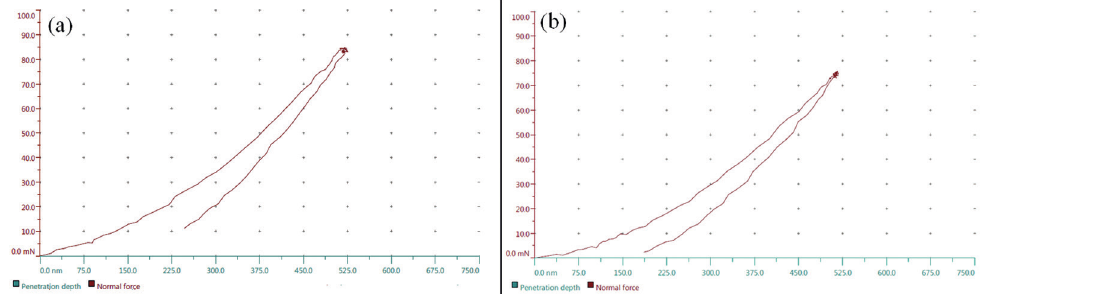
Figure 6: Load vs displacement curve for DLC films obtained by (a) Active screen total system, (b) Active screen partial system. Table 2: Average critical load for DLC films.